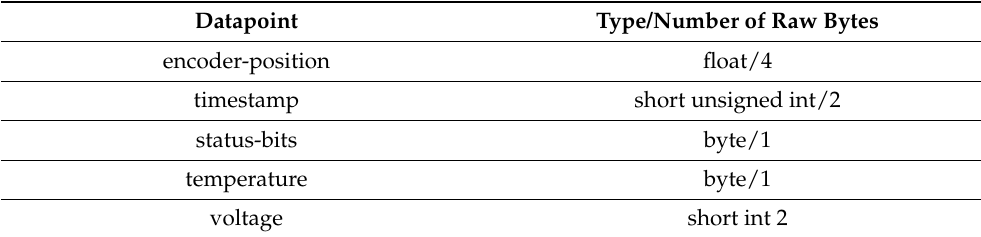
Table 1. Datapoints of interest. Types refer to typical C-language